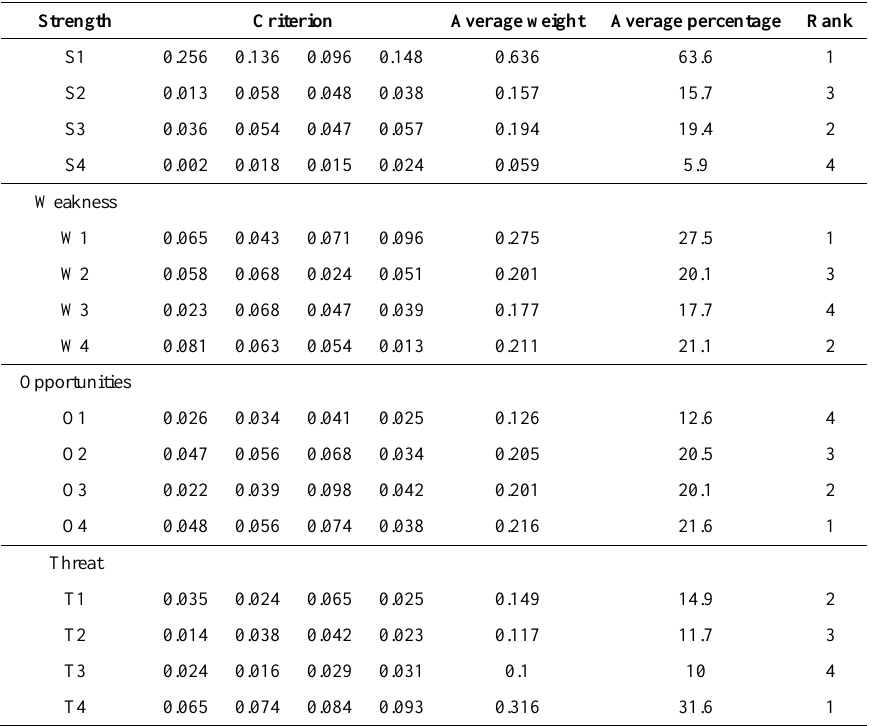
Table 5. SWOT-AHP weightage and